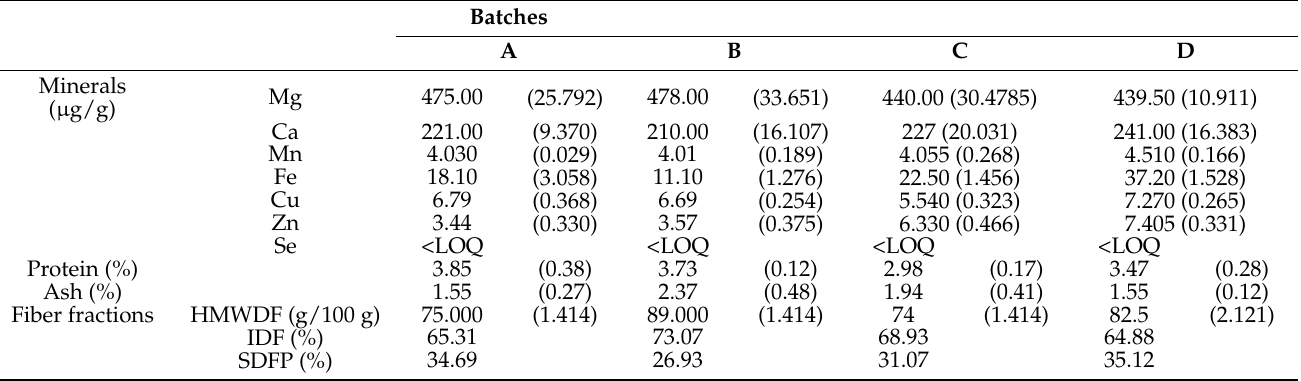
Table 3. Mineral and fiber mean content (standard deviation) of A–C apple pomace powder (APP)